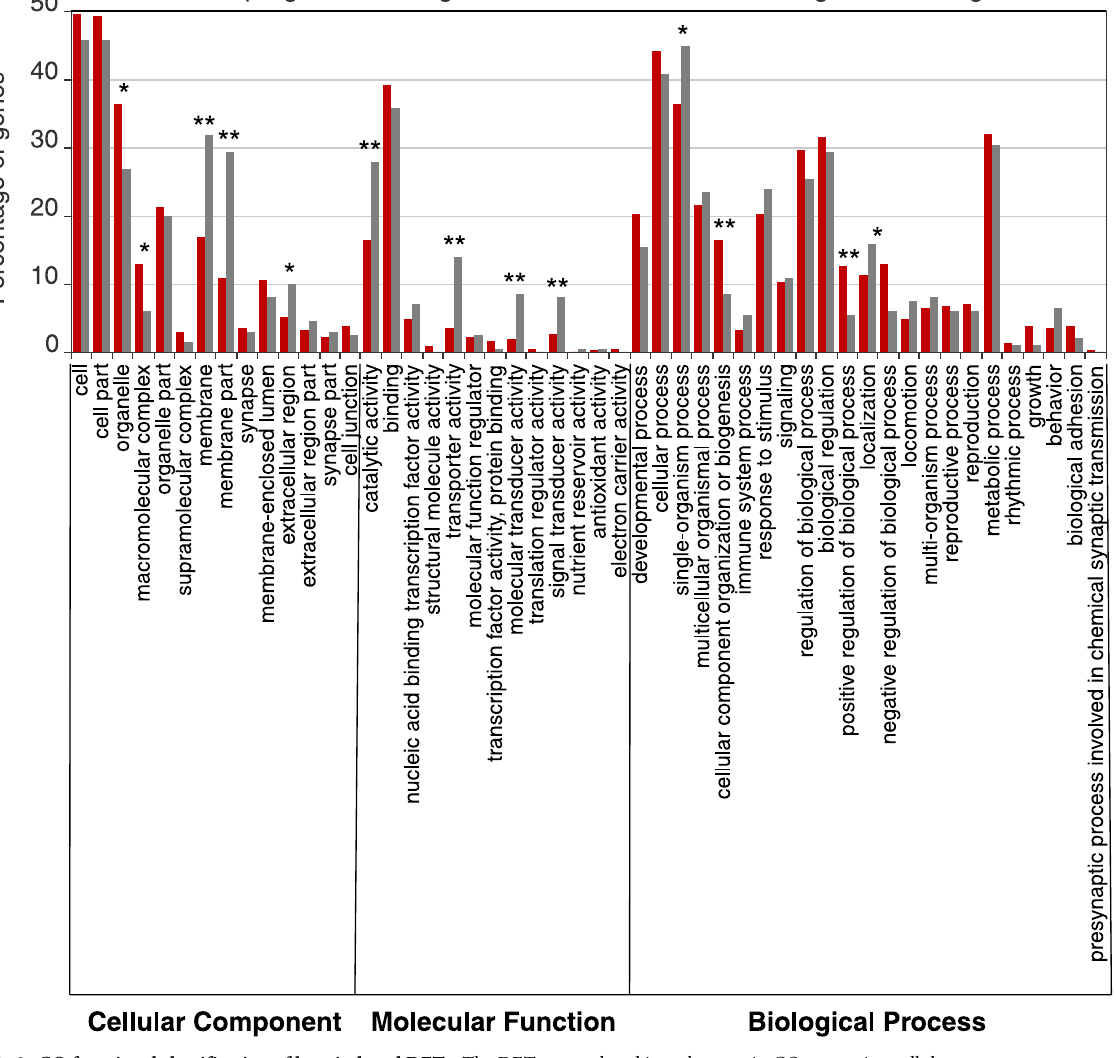
Fig 2. GO functional classification of heat induced DETs. The DETs were placed into three main GO categories: cellular component, molecular function, biological process. Asterisks indicate significant difference ( � indicates p < 0.05, �� indicates p < 0.01).